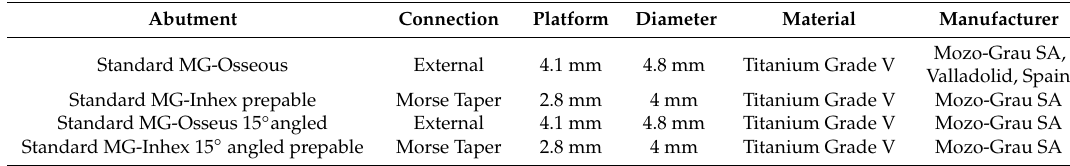
Table 2. Characteristics of the abutments used.